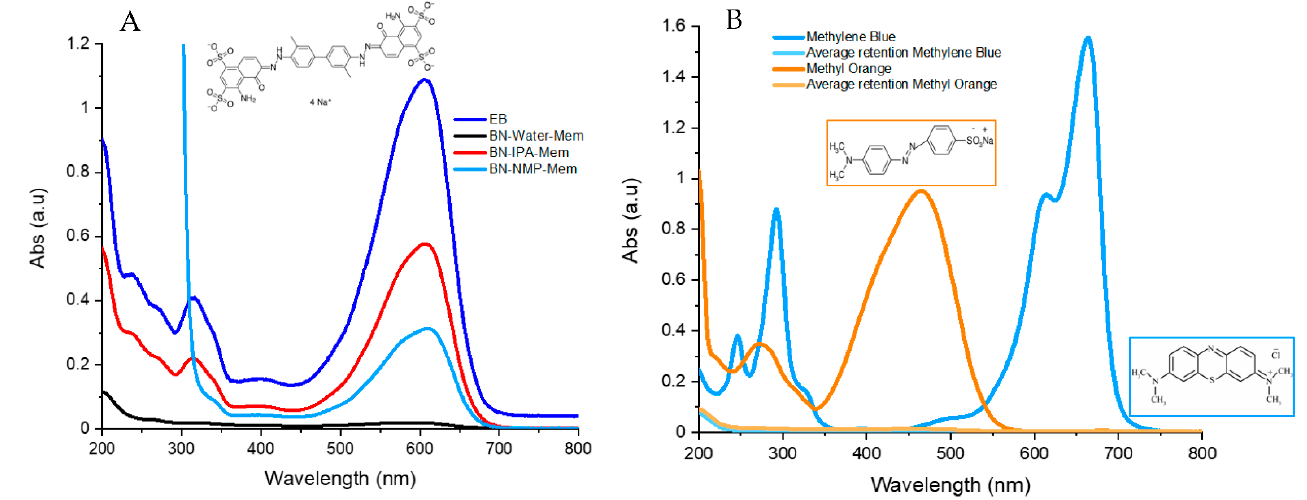
Figure 9. UV-Vis spectra showing the average retention of ( A ) 20 mL of Evans blue (15 µM) through BN membranes made from exfoliation in NMP, IPA and Millipore water. ( B ) Methyl orange (50 µm) and methylene blue (27 µm) through BN membranes exfoliated in Millipore water.